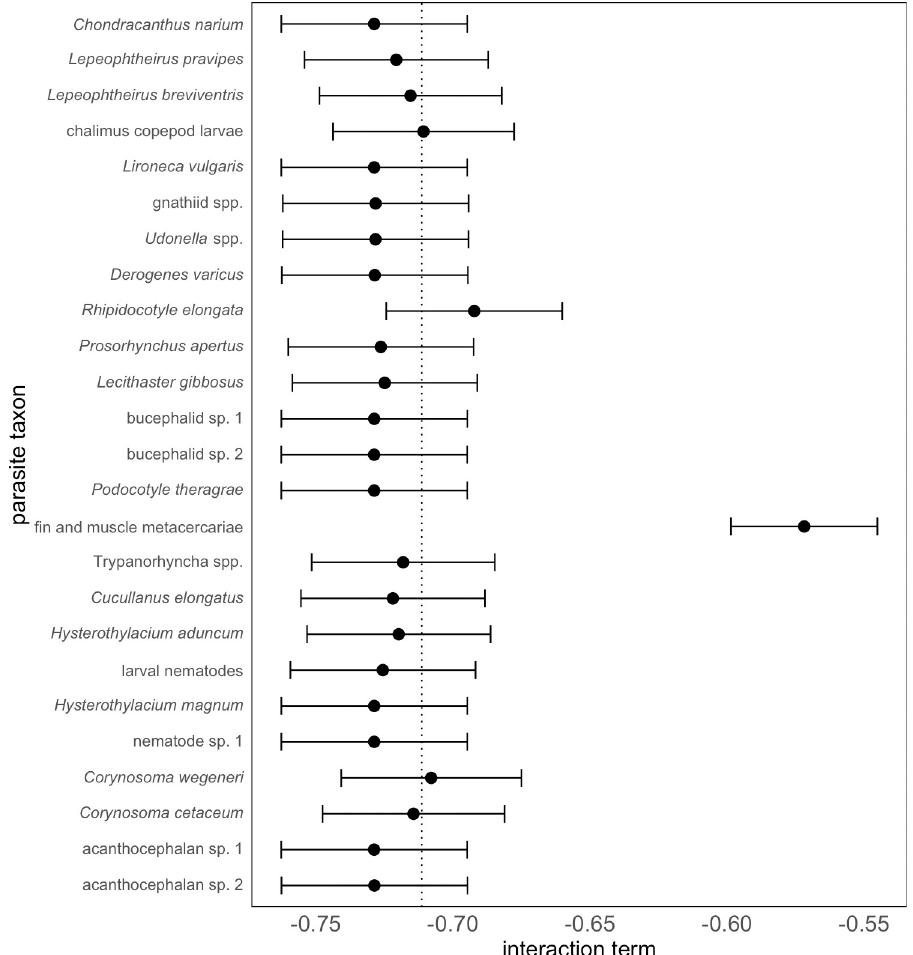
Fig 4. Random slopes for each parasite taxon’s response to the host color � sex interaction, from GLMM for parasite abundance. The across-parasite-taxa fixed effect of the interaction term is indicated with a dotted vertical line. A negative sex � color interaction indicates that the difference in parasite burden between blue and brown males is greater than the difference in parasite burden between blue and brown females; in other words, the more negative the interaction, the more parasites blue males carry compared to all other sex–color